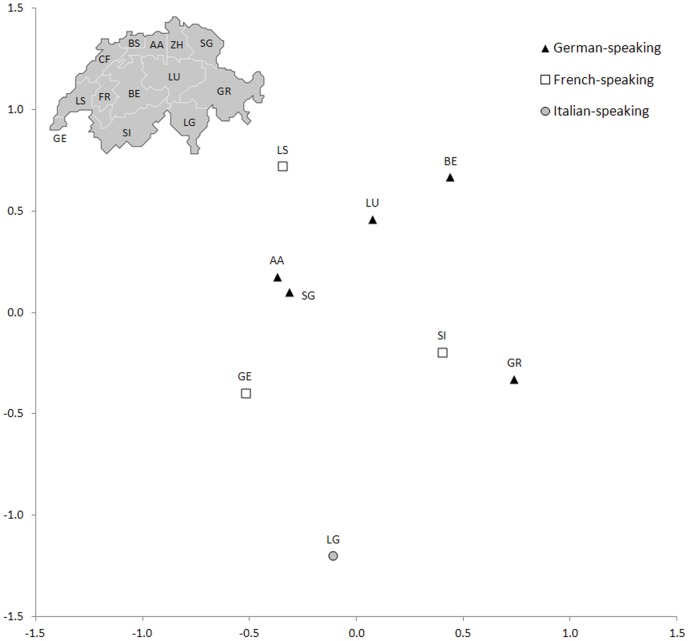
Multidimensional scaling (MDS) analysis of 9 Swiss regions based on mean Reynold's genetic distances computed for 5 HLA loci (HLA-A, -B, -C, -DRB1 and -DQB1).Symbols refer to the language spoken in each region. The stress value is 0.142 (indicating a rather good fit of the graphical representation to the original distance matrix). AA: Aargau-Solothurn, BE: Bern, BS: Basel, GE: Genève, GR: Graubünden, LG: Lugano (Svizzera Italiana), LS: Lausanne (Vaud), LU: Luzern (Zentralschweiz), SG: St. Gallen (Nordost-Schweiz), SI: Sion (Valais) and ZH: Zürich.